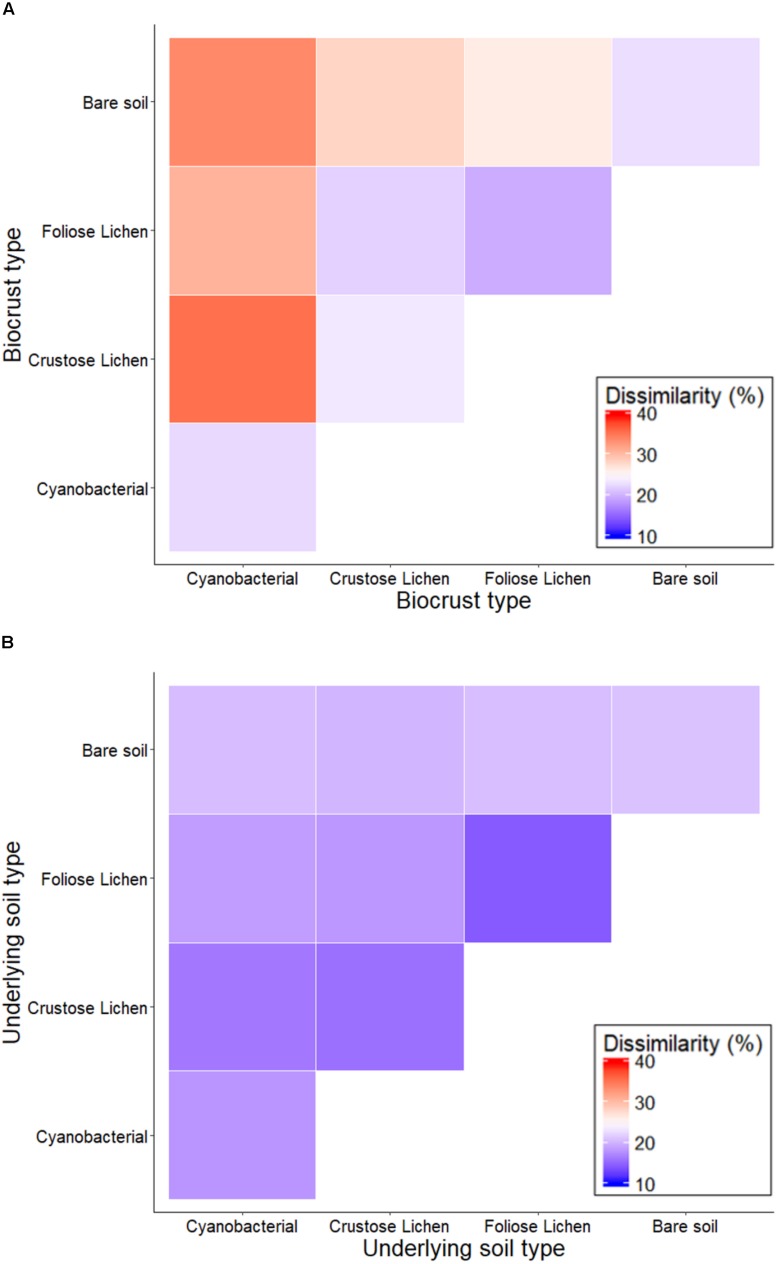
Percentage dissimilarity when comparing family-level intra- and inter-crust microbial communities in (A) Top (bare soil and biocrust) and (B) Bottom (underlying soil) layer sampled from an undisturbed vegetated site in Western Australia.